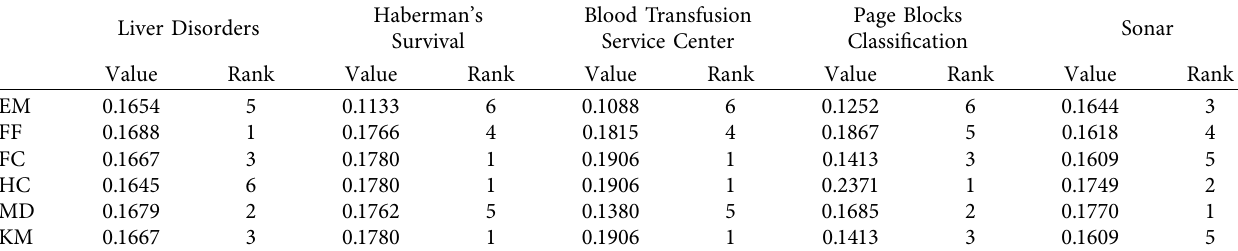
Table 8: Rankings of the PROMETHEE II for the five assigned UCI data sets.